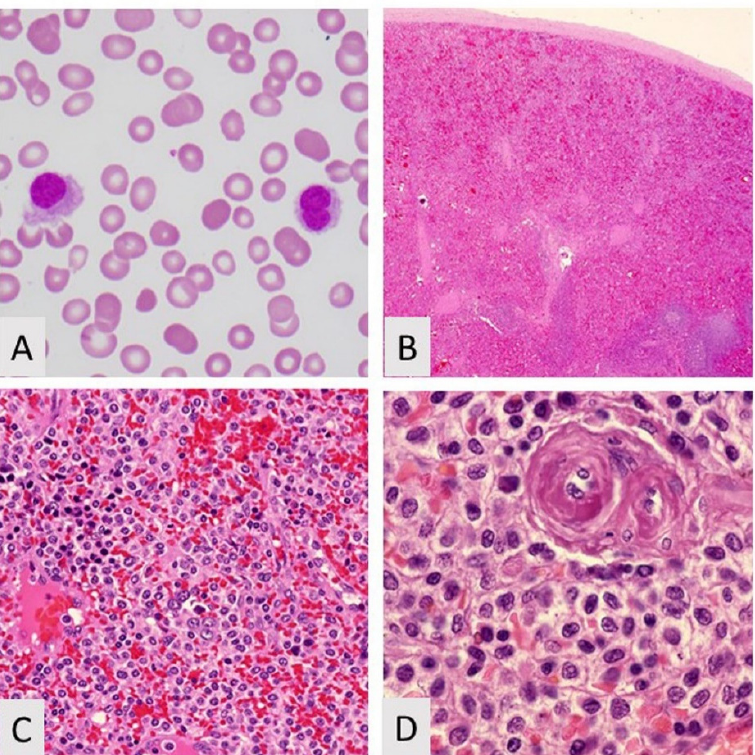
Figure 3. Hairy cell leukemia. ( A ) Peripheral blood showing hairy cell, Wright–Giemsa, 400 × ; ( B ) Low power of spleen showing blood lakes H&R, 20 × ; ( C ) Intermediate power showing hairy cell leukemia and nucleated red blood cells, H&E, 200 × ; ( D ) Hairy cell leukemia showing cells with abundant cytoplasm, H&E, 400 ×